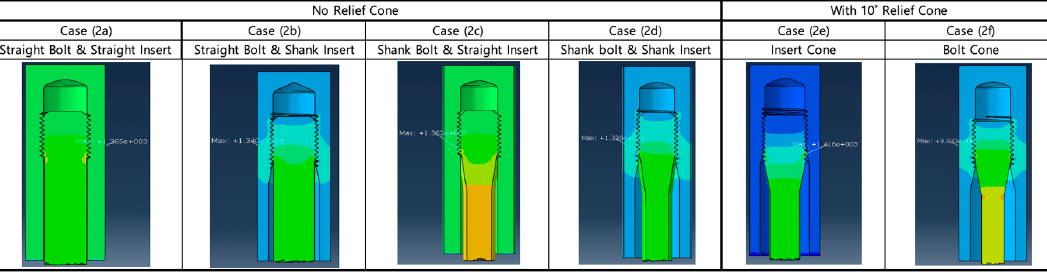
Figure 15. 3D Bolt joint models with varying parameters (straight / shank and with / without a relief cone).